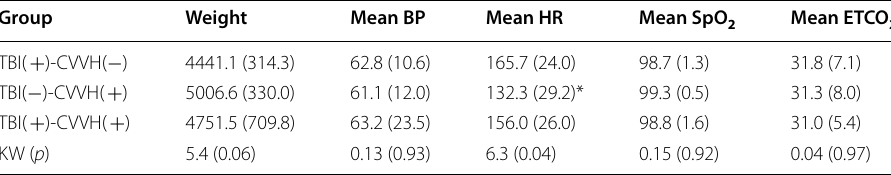
Table 1 Basal data for all groups